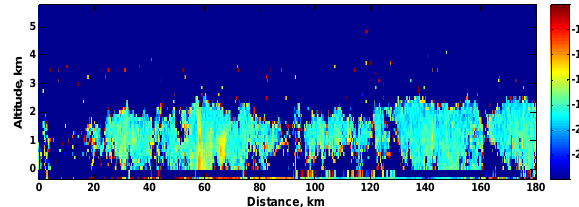
Figure 9: Image of linear depolarization ratio (LDR) obtained by the ACR. The most probable value of LDR inside the clouds is -19.2 dB, while bands of higher LDR are also found around locations at 30, 58, 68, and 143 km. These high LDR bands are indicative of non-spherical ice particles which can change the polarization of scattered microwave emission. Nevertheless, quantitative retrieval of ice from the LDR data is difficult in this case because the LDR signal is very weak (only 1-1.5 dB).